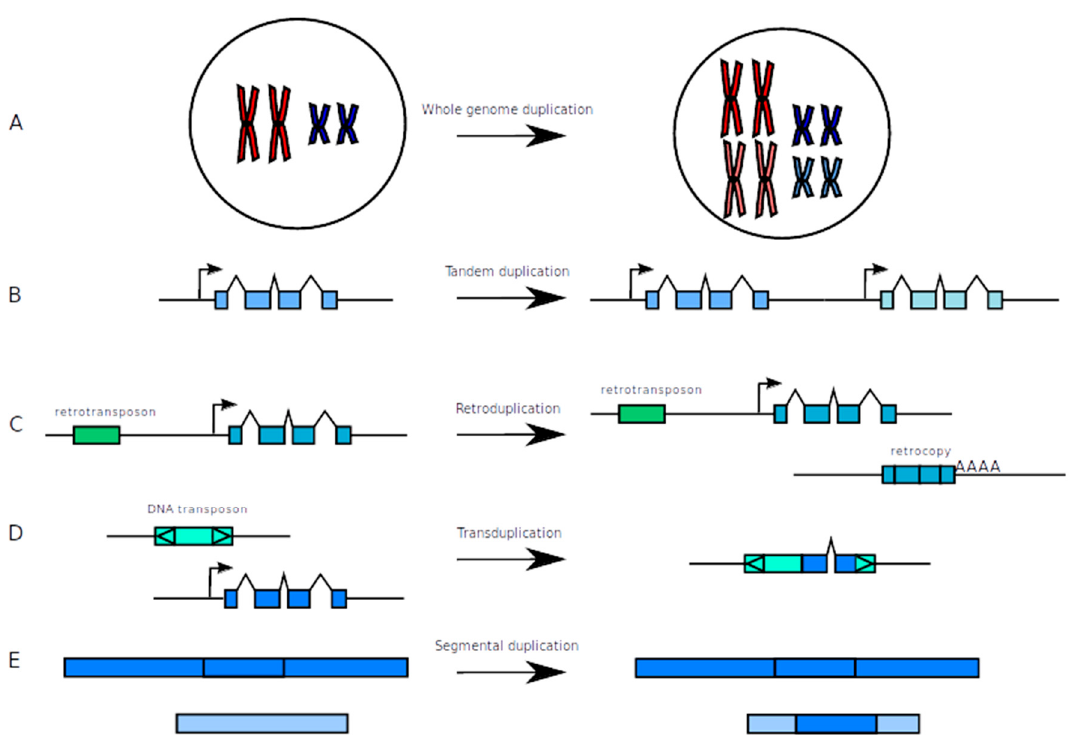
Figure 1. The different types of duplications. ( A ) Whole genome duplication which implies complete chromosome duplication. ( B ) Tandem duplications which produce identical adjacent sequences. ( C ) Retroduplication, which produces a retrocopy of a gene devoid of introns and with a polyA tail. ( D ) Transduplication in which a DNA transposon acquires fragments of genes. ( E ) Segmental duplications which correspond to long stretches of duplicated sequences with high identity.